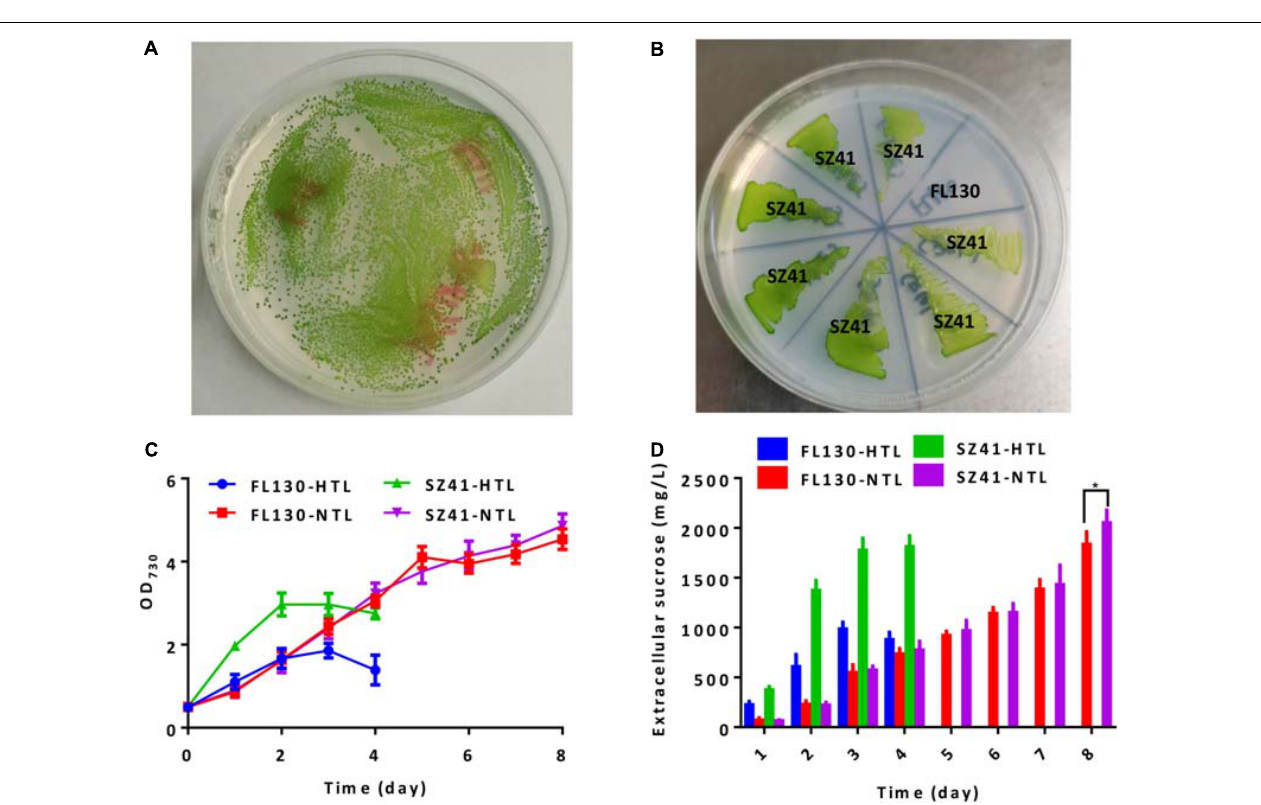
FIGURE 3 | Effects of the AtpA-C252F mutation on growth, tolerance, and sucrose synthesis of a PCC 7942 derived cell factory. (A) Tolerant transformants (with the AtpA-C252F mutation) of FL130 on BG11 agar plates after 2 days of cultivation under high light and high temperature conditions (45 ◦ C with 300 µ mol photons/m 2 /s illumination). (B) FL130 and the derived SZ41 strain (FL130-AtpA-C252F) grown on BG11 plates at 45 ◦ C with 300 µ mol photons/m 2 /s illumination. (C) Cell growth of FL130 and SZ41 under normal (NTL, 30 ◦ C with 100 µ mol photons/m 2 /s illumination) and stressful (HTL, 40 ◦ C with 400 µ mol photons/m 2 /s